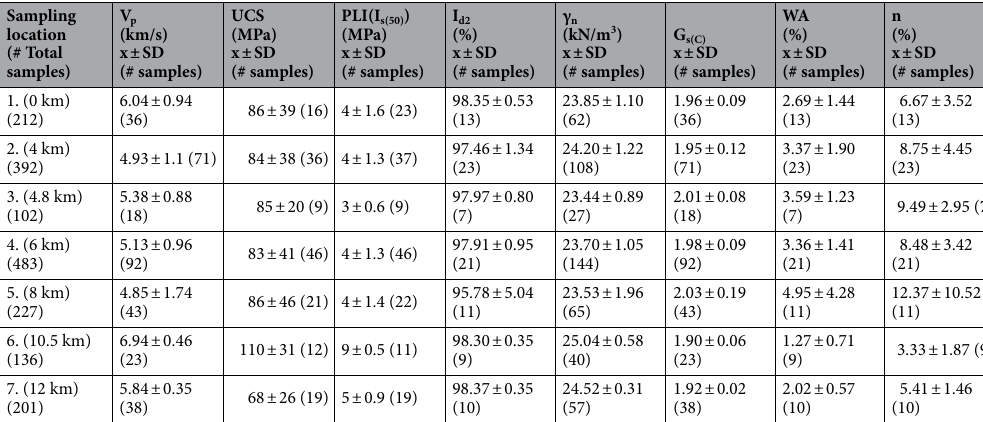
Table 2. Number of samples used for each test and the range within one standard deviation of the average. x = average and SD = standard deviation.